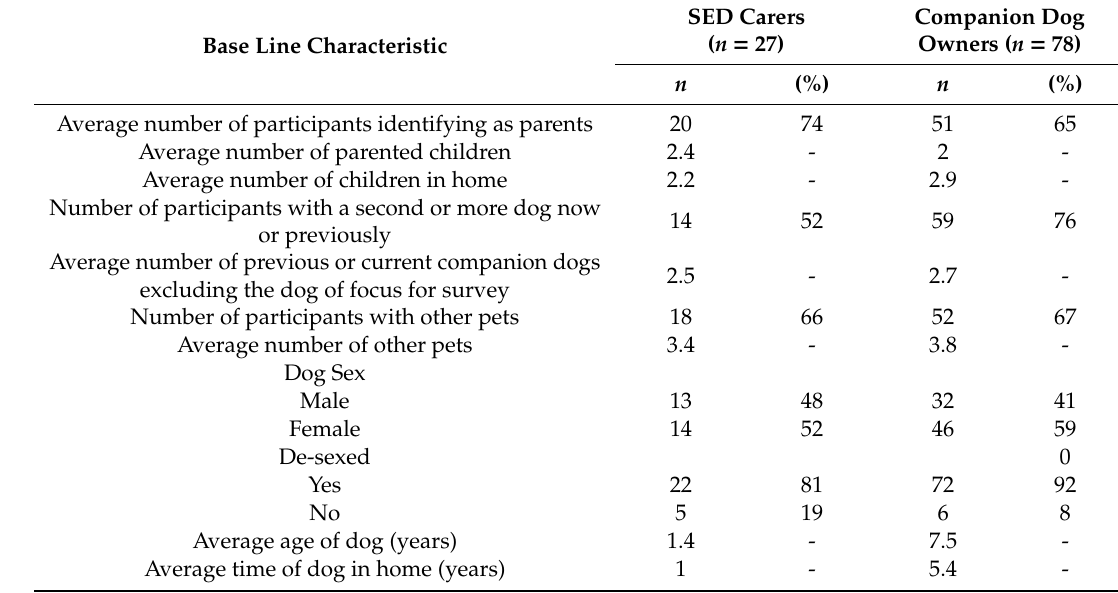
Table 1. Parental and Pet-Keeping history of Participants and Demographics of Their Study